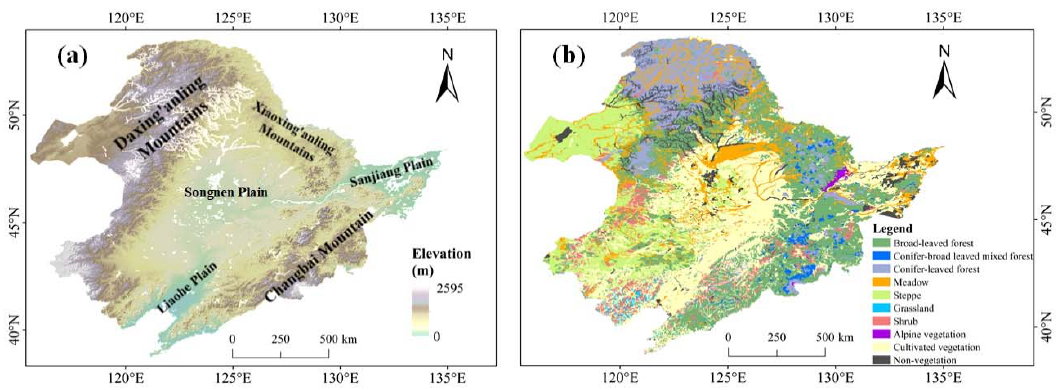
Figure 1. Elevation map ( a ) and vegetation types ( b ) in Northeast China (NEC)